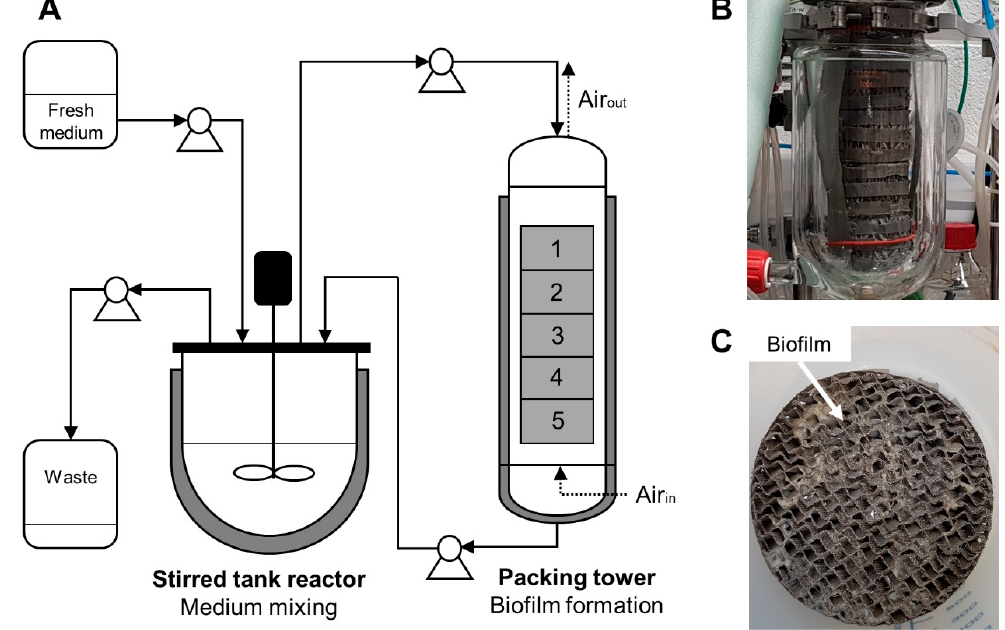
Figure 1. ( A ) Experimental set-up of the lab-scale trickle-bed biofilm reactor. ( B ) Packing tower